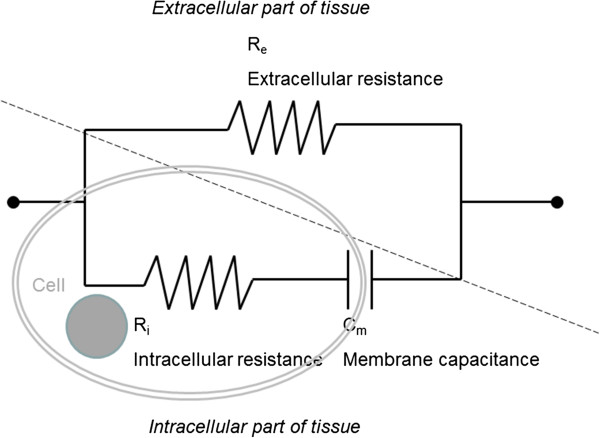
The simplified equivalent three-element electrical circuit model fortissues. The simplified equivalent three-element model to interpret theelectrical properties of biological tissues, with Re (extracellularresistance), Ri (intracellular resistance), and Cm (membranecapacitance).